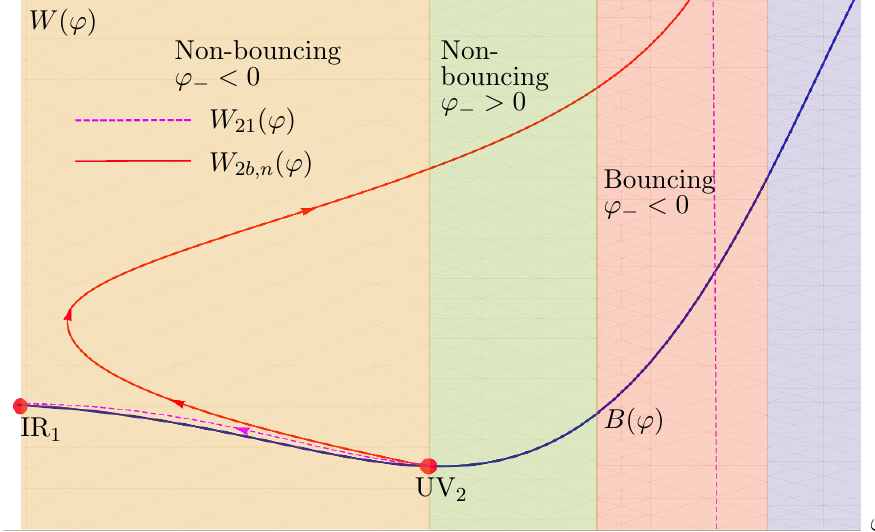
Figure 28. Superpotential W 2 b;n ( ’ ) for a bouncing (cid:13)ows starting from UV 2 . For bouncing (cid:13)ows, the source is negative. This type of (cid:13)ow also comes from a curvature deformation of the (cid:13)at case (cid:13)ow W 21 (dotted line) and exist for all values of the